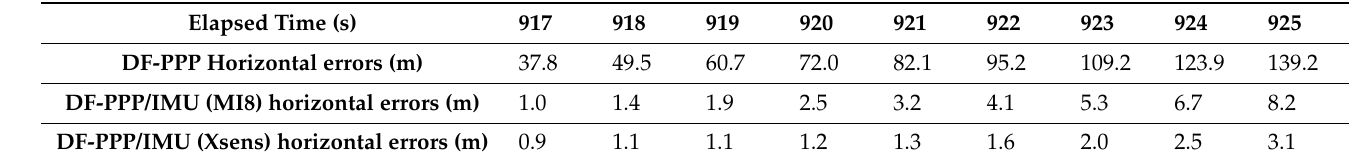
Table 6. Horizontal errors growth with different sensor fusion combinations for dual-frequency PPP over Outage B.